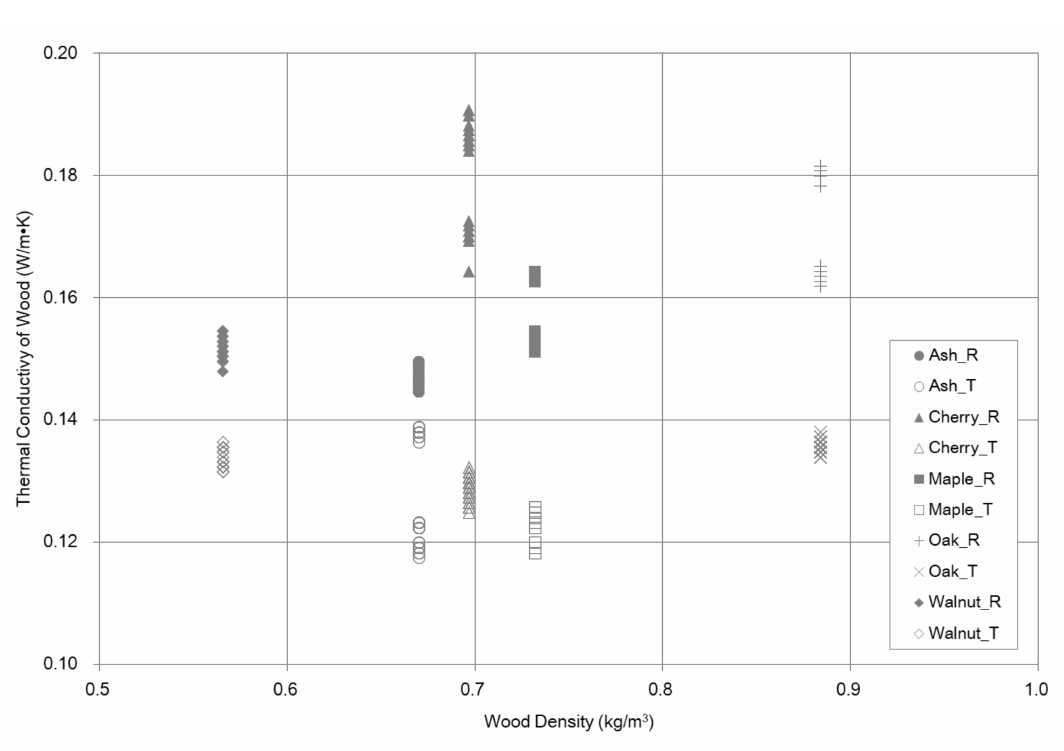
Figure 5. Thermal conductivity of wood species in radial and tangential